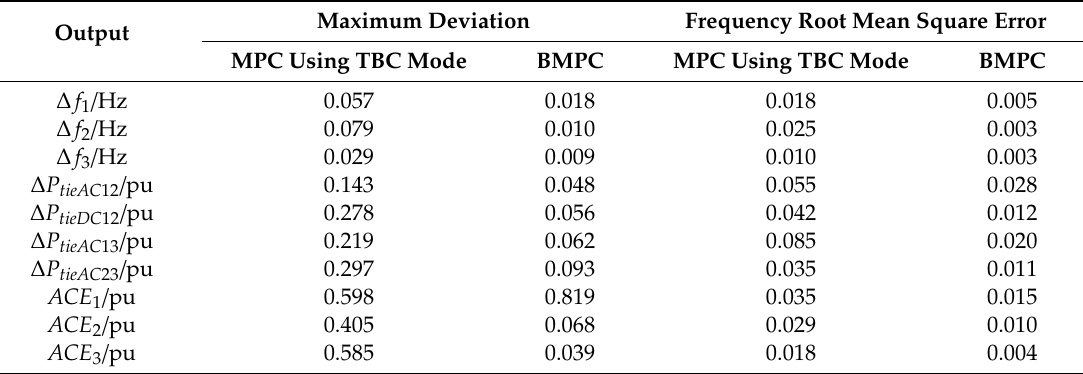
Table 5. Dynamic response performance comparison of two control methods under output power of wind power random disturbance. TBC, tie-line frequency bias control.